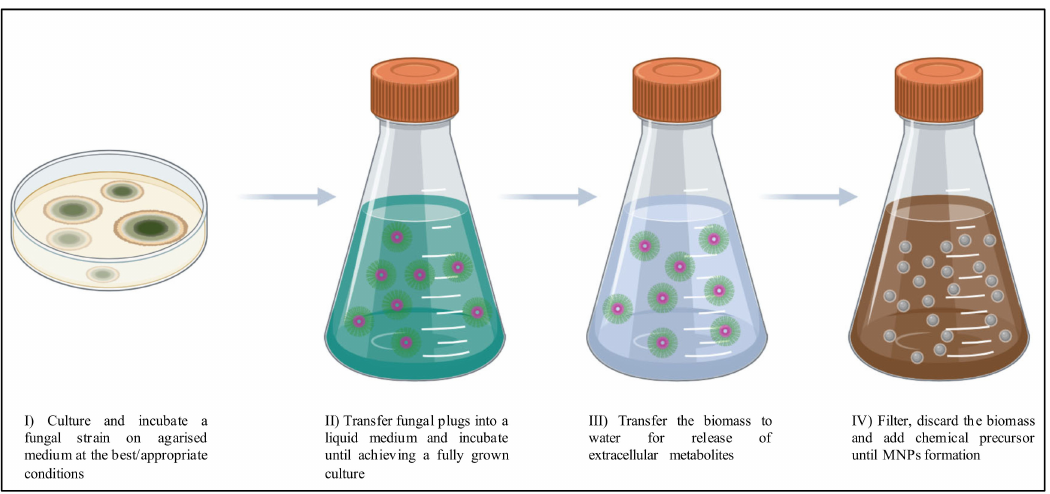
Figure 1. Main steps in mycogenic synthesis of